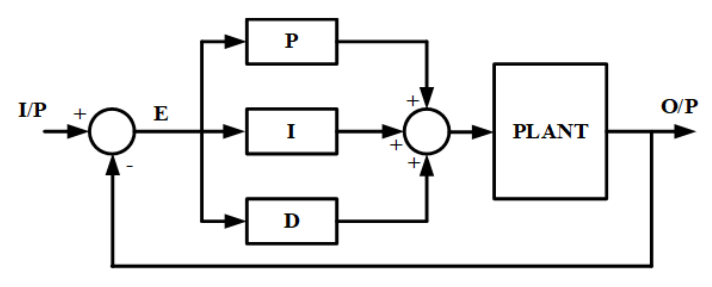
Figure 4. Basic block diagram of a proportional integral derivative (PID)